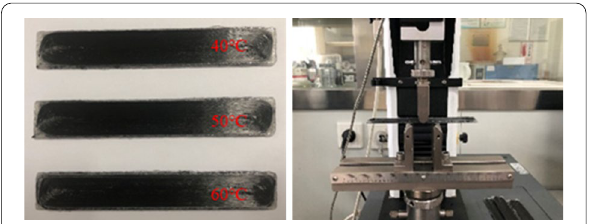
Figure 7 Testing specimens and three-point bending test